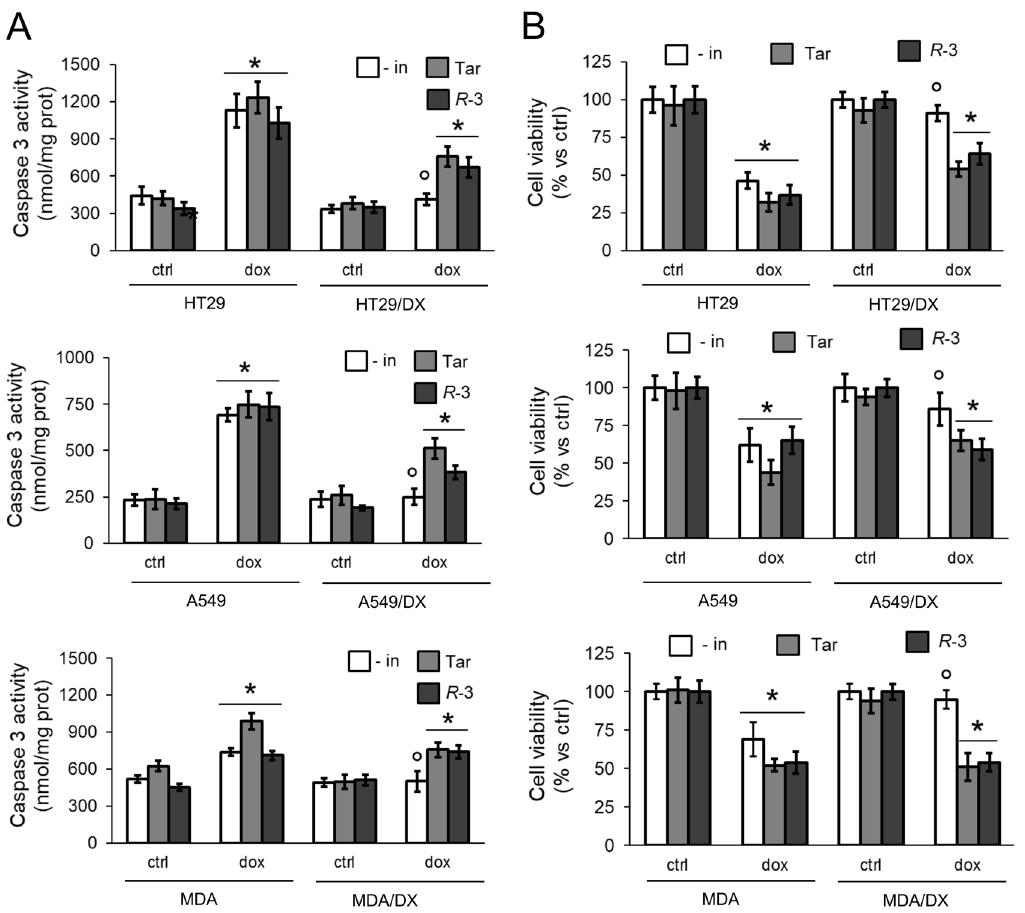
Figure 2. R -3 increases doxorubicin-induced apoptosis and cytotoxicity in Pgp-expressing cells. ( a ) Human colon cancer HT29 cells, non-small cell lung cancer A549 cells, triple-negative breast cancer MDA-MB-231 cells, and their doxorubicin (DX)-resistant variants were incubated 24 h ( a ) or 48 h ( b ), in fresh medium (ctrl), without inhibitors (- in) or with 75 nM Tariquidar (Tar) or 75 nM R -3. When indicated, 5 µ M doxorubicin (dox) was added. ( a ) Activity of caspase 3 was measured fluorimetrically in duplicates ( n = 3). Data are means ± SD. * p < 0.001: treated cells vs. respective ctrl cells; ° p < 0.001: DX cells vs. parental cells. ( b ) Cell viability was measured by a chemiluminescence-based assay in quadruplicates. Data are means ± SD ( n = 3). * p < 0.001: treated cells vs. respective ctrl cells; ° p < 0.05: DX cells vs. parental cells.